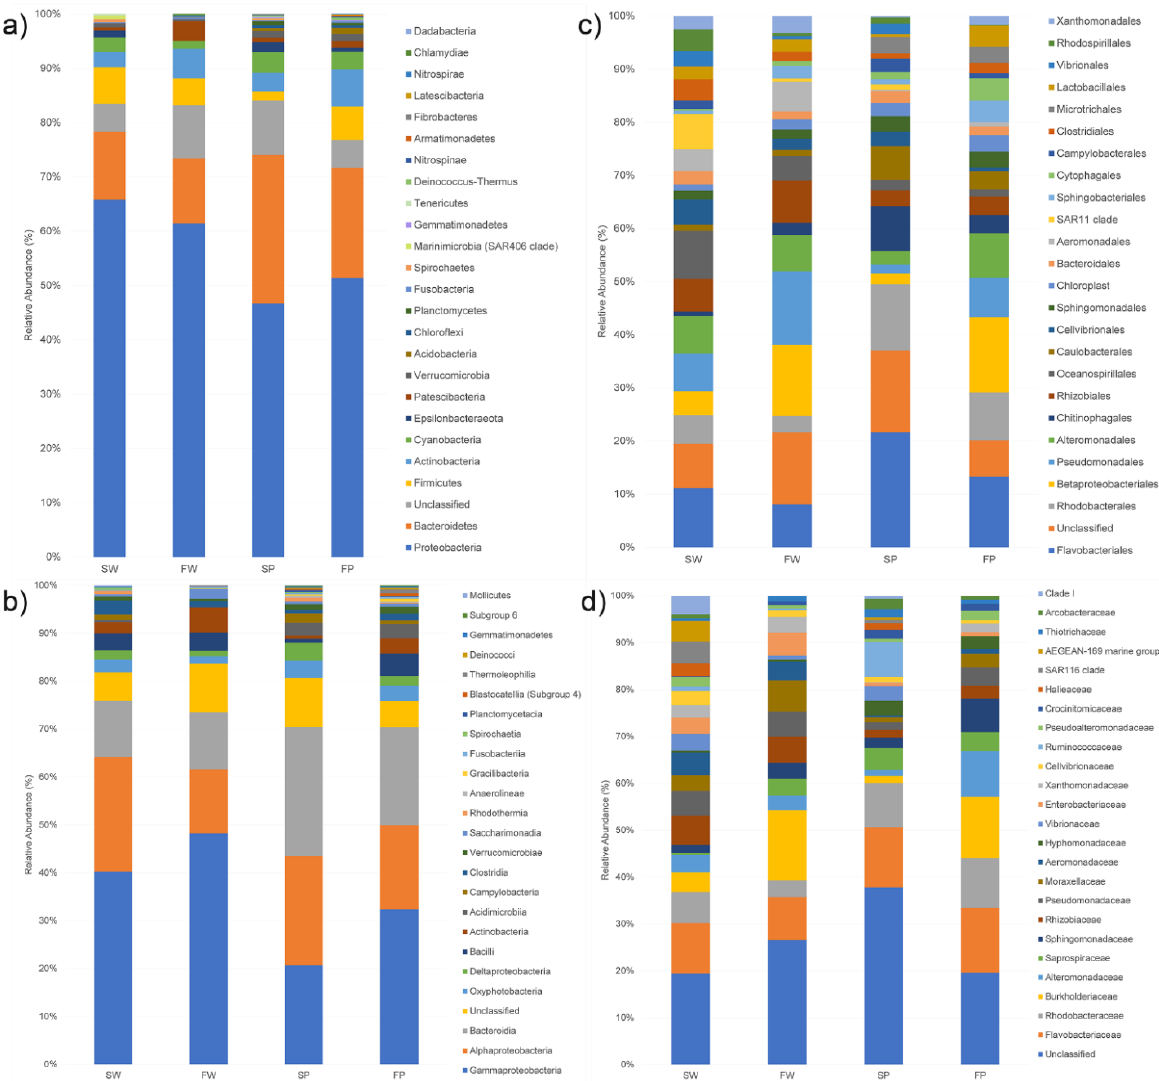
Figure 2. Bar plots reporting the relative percentage abundance of the bacterial phyla ( a ), classes ( b ), orders ( c ), and families ( d ) in seawater (SW), freshwater (FW), and the corresponding PE wastes (SP and FP). Each bar represents the mean of the grouped samples. Microbial composition was determined taking into account only the 25 most abundant taxa.